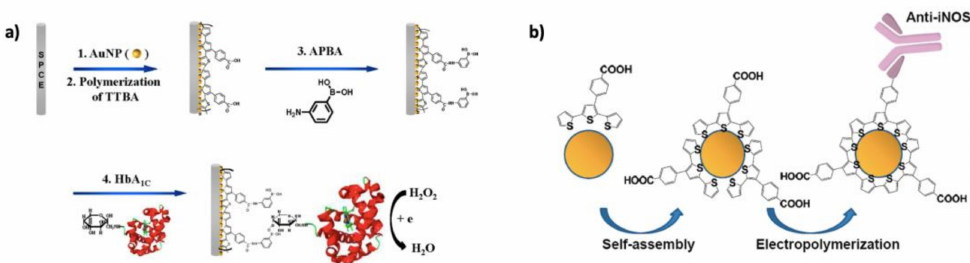
Figure 7. pTTP sensors for the detection of ( a ) glycated hemoglobin and ( b ) i-NOS. Adapted with permission from ref. [533] and ref. [539] Copyright 2013 and 2011, American Chemical Society.